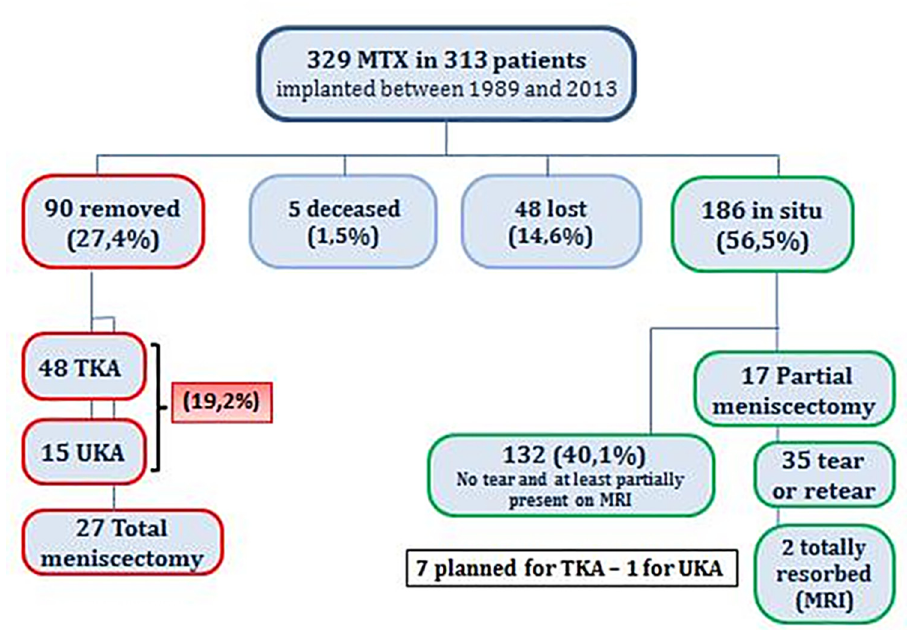
Fig 1. Outcomes of meniscal allograft transplantations